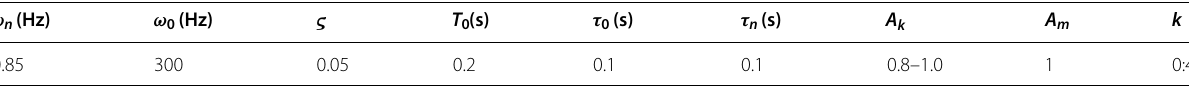
Table 1 Parameters applied in the simulation signal